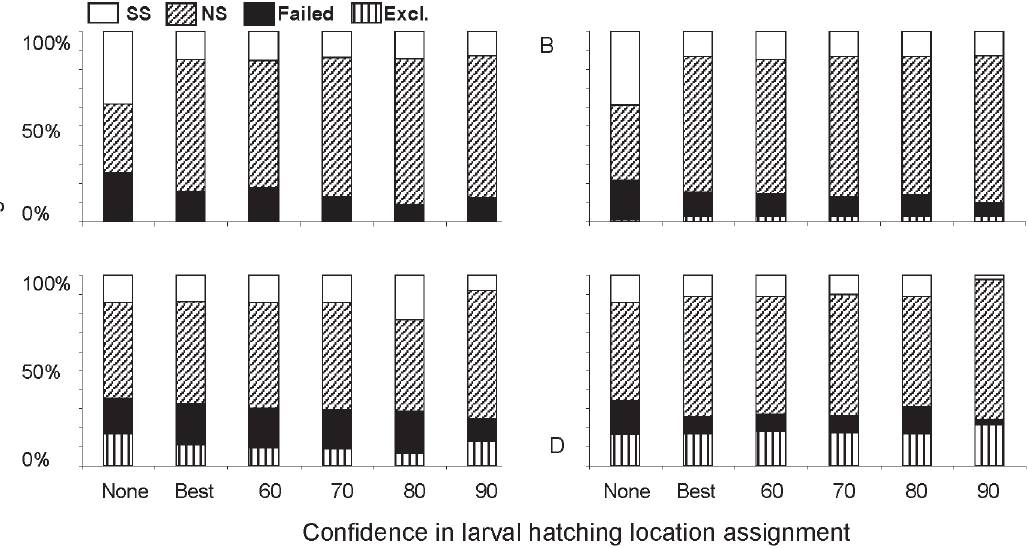
Fig 3. Predicted origins of juvenile yellow perch collected in open waters of western Lake Erie using microsatellites (seven loci) from larvae collected during 2006 (a: all larvae; b: only larvae < 8 mm total length, TL) and 2007 (c: all larvae; d: only larvae < 8 mm TL). A total of N = 119 and N = 167 juveniles were analyzed during 2006 and 2007. Juveniles with < 30% likelihood of originating within a population were “ excluded ” (i.e., they were not included in the analysis); juveniles with a 30 to 70% likelihood were considered “ failed, ” (i.e., we had little confidence in their hatching-location assignment); and juveniles with a probability > 70% were assigned to the NS or SS breeding population with high confidence. Certainty in hatching locations of larvae used to develop classification functions was as follows: None = null assignments based on capture location (i.e., no backtracking used); Best = larvae assigned to single most likely hatching location (SS or NS) based on backtracking; and 60, 70, 80, 90 = larvae assigned to hatching location after backtracking revision with 60, 70, 80, 90% levels of certainty in hatching origin, respectively.